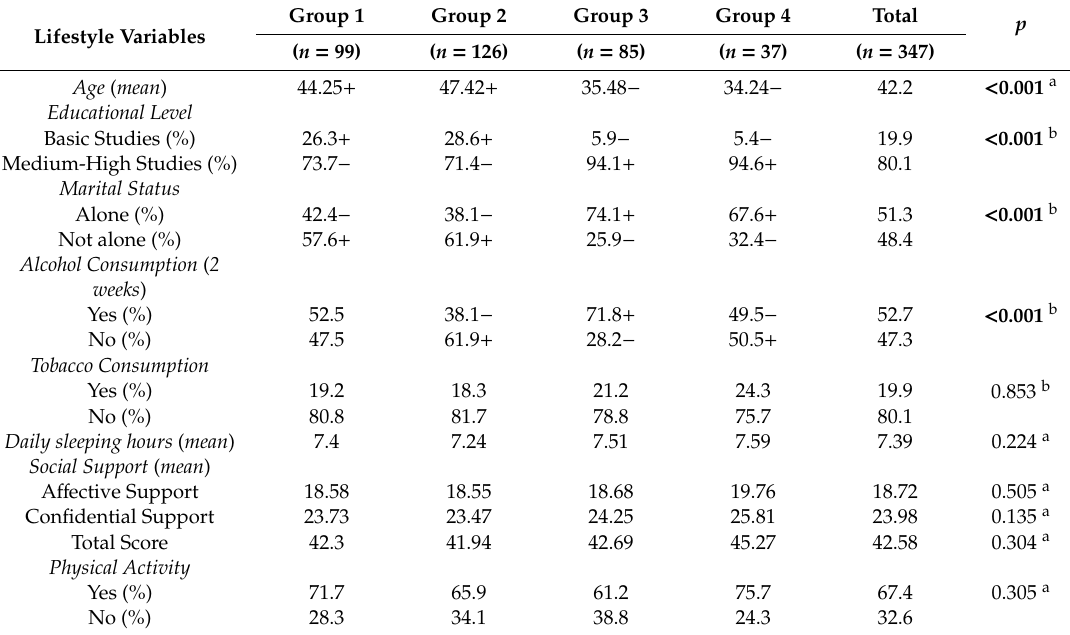
Table 4. Patterns of feminine role conformity and lifestyles